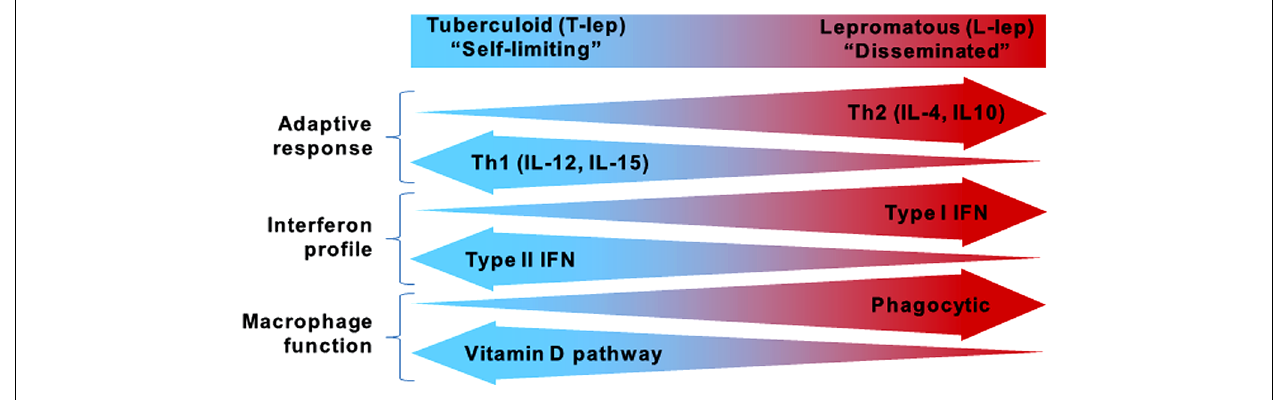
FIGURE 1 |The spectrum of leprosy. Characteristics of the innate and adaptive immune responses in either end of the leprosy